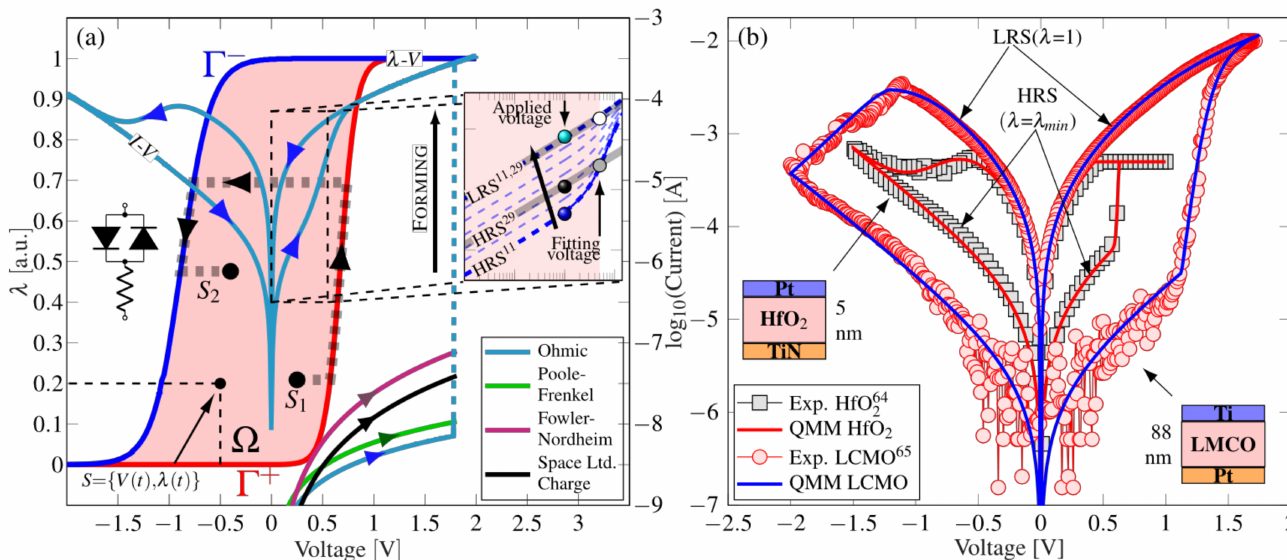
Figure 2. ( a ) Hysteron model with logistic ridge functions Γ + (Equation (3)) and Γ − (Equation (4)). Ω is the space of feasible states S . The black thick faded line superimposed on the hysteron model indicates the trajectory of the state variable λ inside Ω from an initial S 1 to a final S 2 state. Note that four transport mechanisms are considered for the pre-forming conduction, with the forming event taking place at the same voltage. The inset in the left shows the equivalent circuit model for the current equation (Equation 1) including the series resistance. The diodes are driven by the memory state of the device and one diode is activated at a time. Typical I-V characteristics for a memdiode [11] obtained via the simulation of the proposed model are superimposed. Current evolution is indicated by the blue arrows. The inset on the right side shows the exponential (HRS) to lineal (LRS) transition by varying the value of λ . The red shaded region indicates the possible voltages applied to the device. I HRS and I LRS currents are pinpointed at a fitting voltage with the grey and white circle markers, respectively. The overestimation of I HRS may occur when considering a linear model [29] for the HRS regime, and lower applied voltages as indicated by the cyan, blue and black ball markers. ( b ) Experimental I-V loops of different materials reported in the literature, fitted with the QMM model: HfO 2 [64] and LMCO